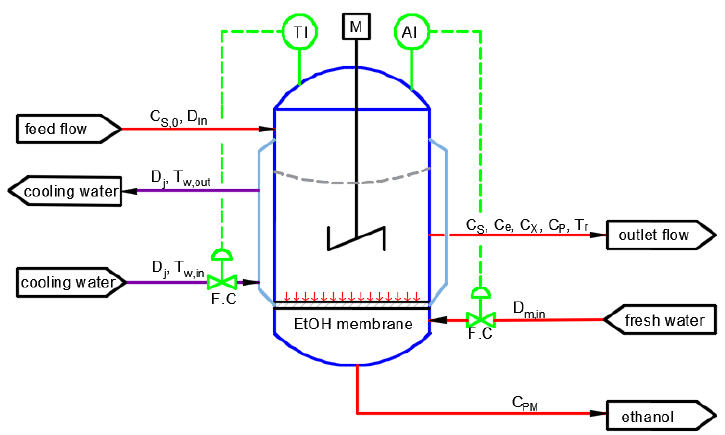
Figure 4. Schematic diagram of the fermentation reactor.